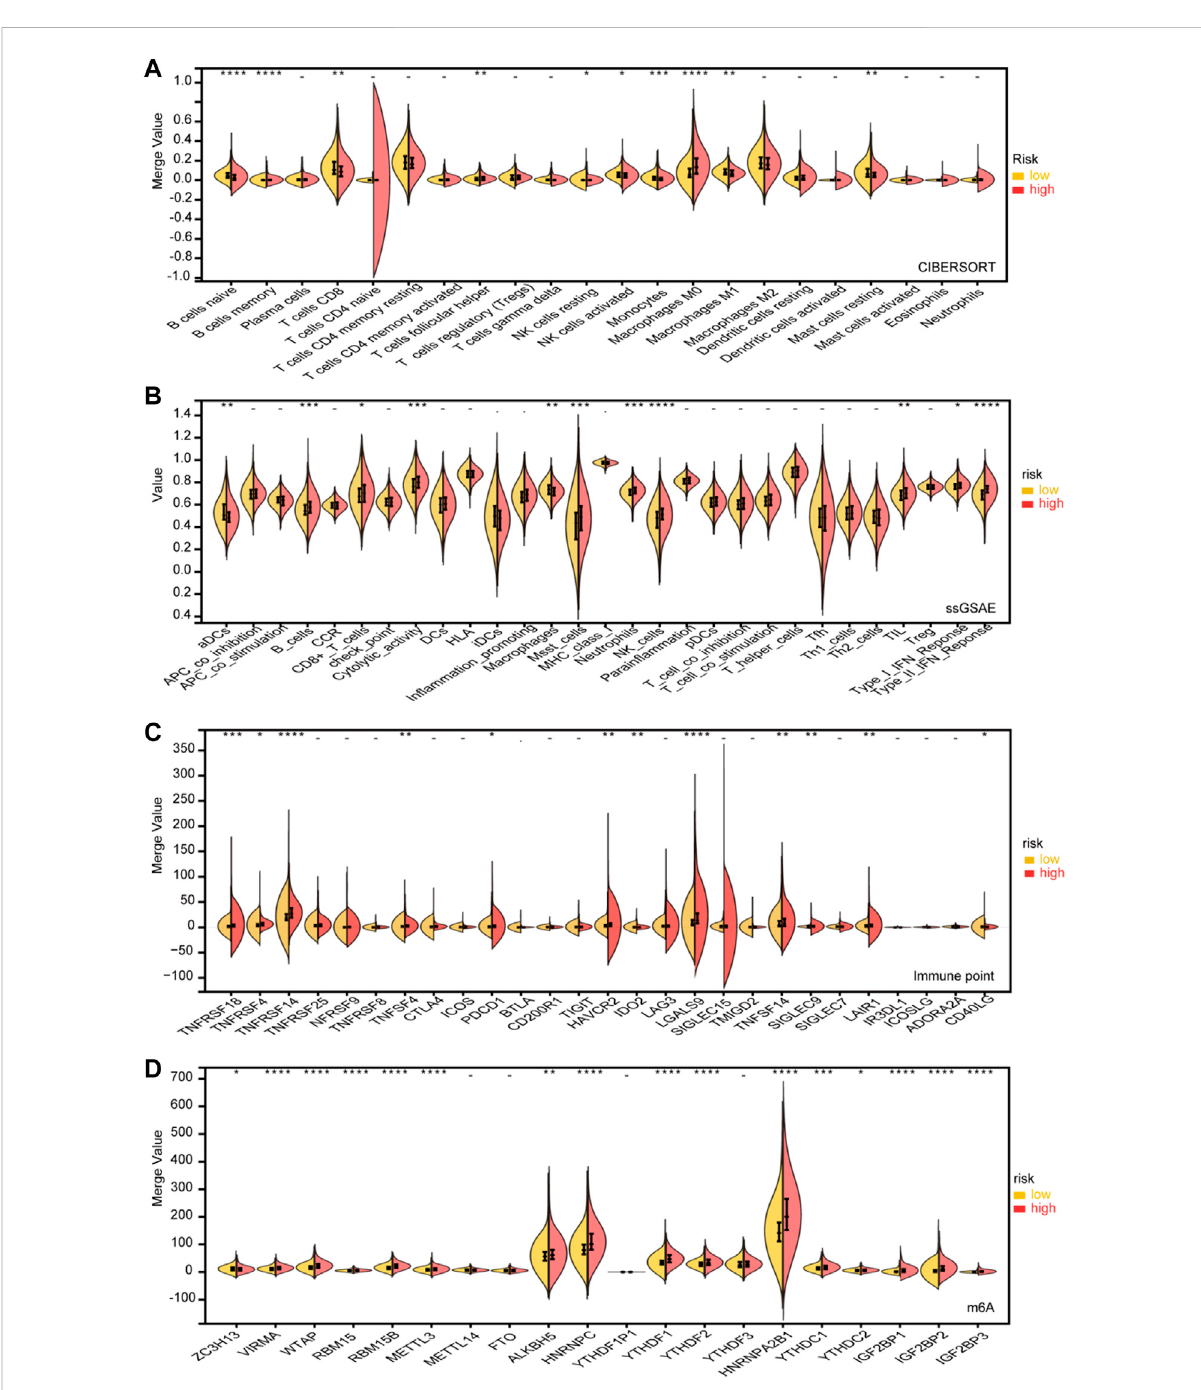
FIGURE 7 Immunein fifi ltrationlevelanalysisforthehigh-andlowriskgroups. (A) CIBERSORT. (B) ssGSEA. (C) Expressionofimmunecheckpointsbetween the high- and low-risk subgroups. (D) Expression of m6A genes between high- and low-risk subgroups ( p < 0.1, * p < 0.05, ** p < 0.01, *** p < 0.001, **** p < 0.0001).